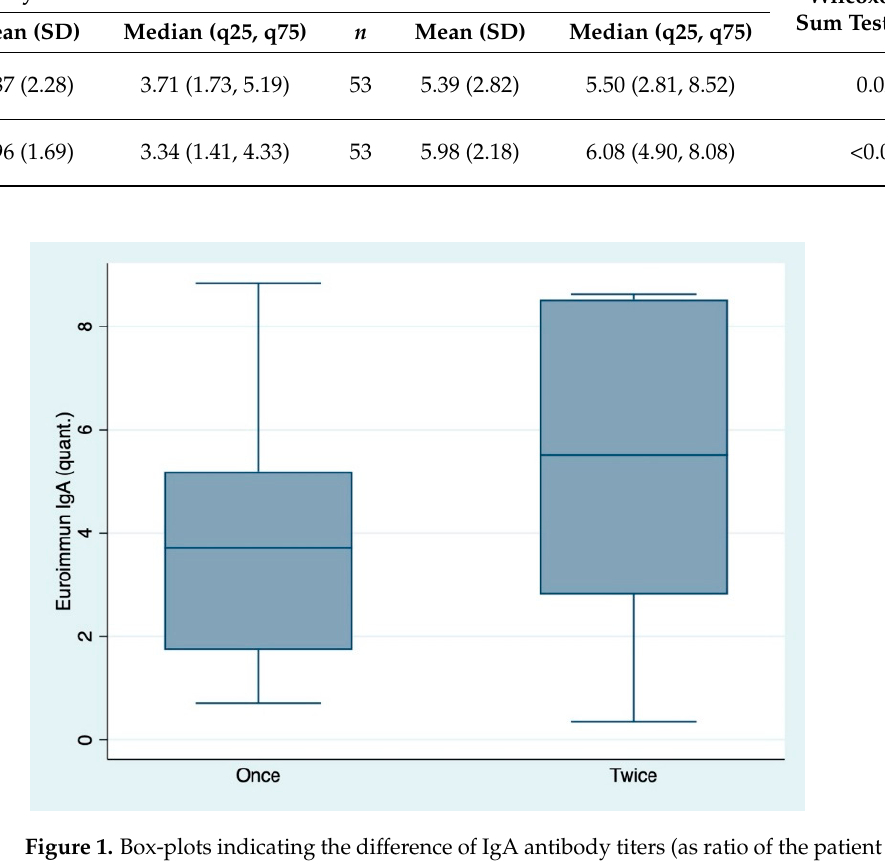
Table 4. Comparison of spike protein antibody titers among individuals who received one or two vaccinations applying Wilcoxon’s rank sum test.